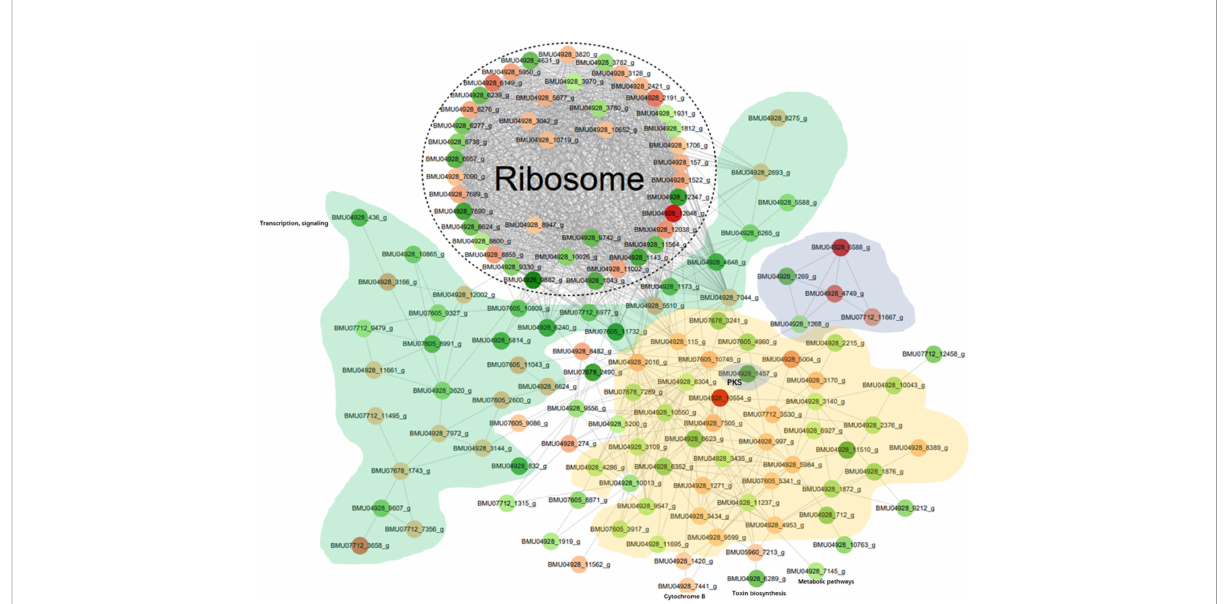
FIGURE 5 Protein-protein interaction (PPI) network of the 100 most up- and down-regulated lactylated proteins between BMU 00512 and BMU 04928. Ribosomal proteins form a dense cluster; proteins primarily involved in signaling, transcription and translation shown in green; metabolic proteins in yellow, histones in light grey, PKS in dark grey, heat shock proteins in